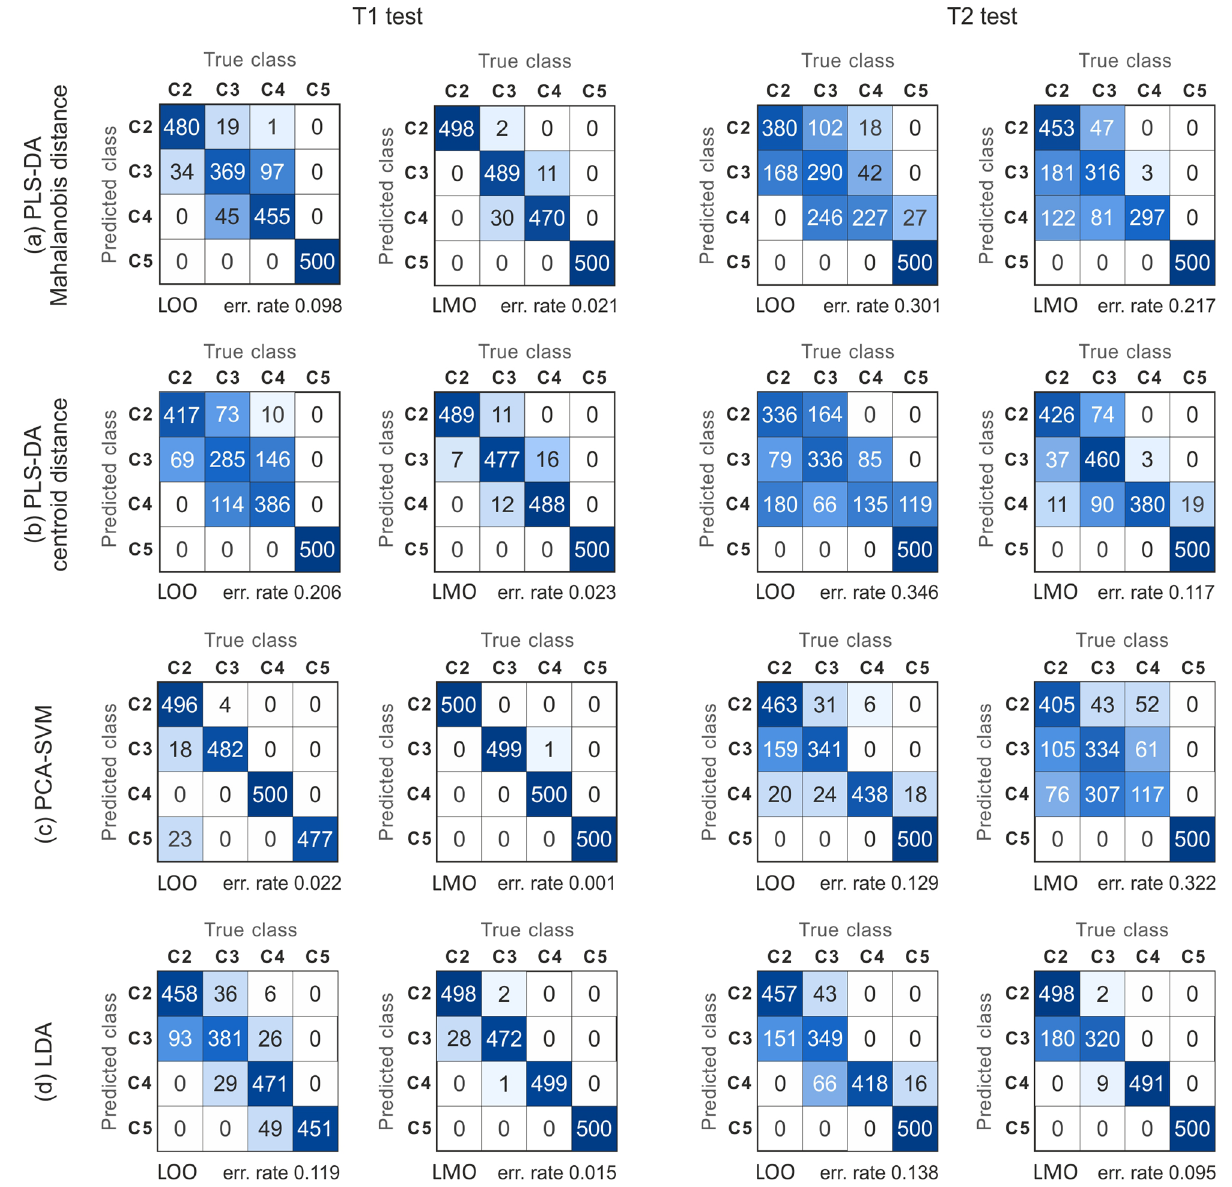
Figure 5. Confusion matrix for the tested classifiers with two textile data sets (the same textiles after custom abrasion test T1 and after the standardized Martindale abrasion test T2) and different validation methods (LOO, LMO). For the PLS-DA classifier, the matrices were computed based on the Mahalanobis distance as well as the centroid distance of the first five output components. The SVM classifier confusion matrices were computed after dimension reduction for five PCA